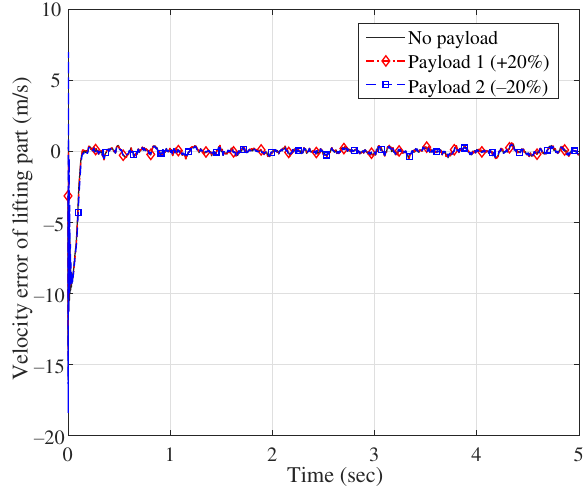
Figure 20. Velocity error of lifting part (Group 3).